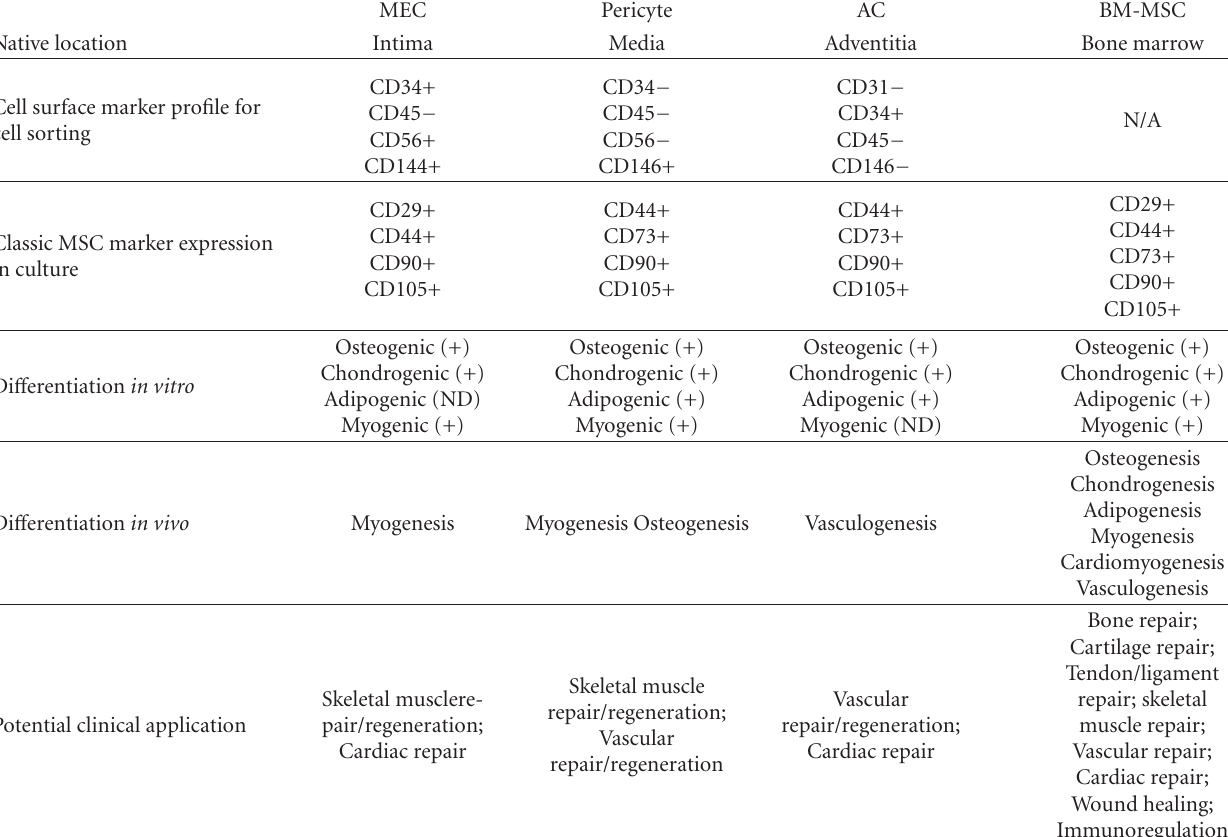
Table 1: Comparison of hBVSC subpopulations and bone marrow MSCs.